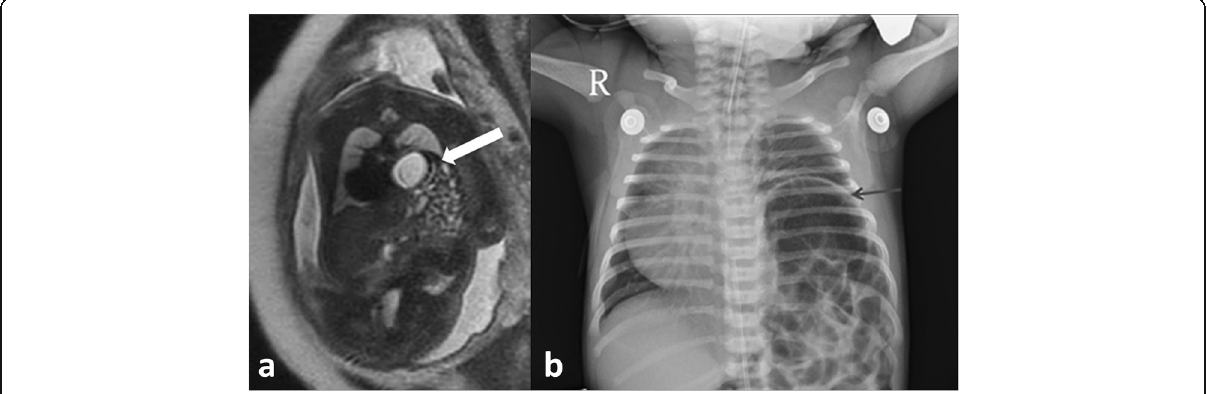
Fig. 3 Thirty-three-year-old G2 P1 L1 at 32 weeks of gestation with features of left-sided eventration. a Coronal T2-weighted MRI image of fetal trunk showing the presence of stomach and small and large bowel loops in the thoracic cavity with an intact diaphragm (white arrow). b Postnatal chest radiograph showing elevated left hemidiaphragm (black arrow) outlined by the lung superiorly and bowel gasses inferiorly